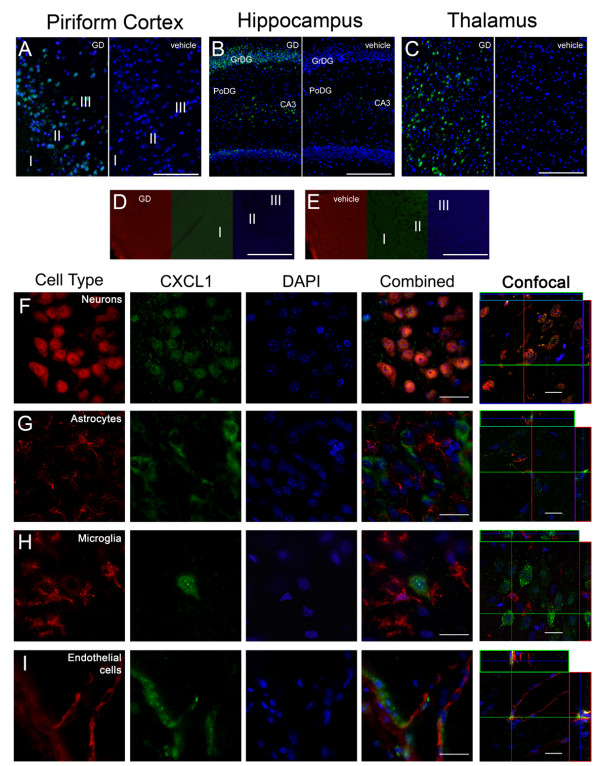
CXCL1 is expressed in neurons and, to a much lesser extent, in endothelial cells after GD-induced SE. Prominent CXCL1 (A-I, green) immunolabeling is present in the piriform cortex, hippocampus and thalamus 12 hours after GD-induced SE (A, B & C; left). CXCL1 is absent in vehicle controls of these same regions (A, B & C; right). In the piriform cortex (A), labeling is observed primarily in layers II and III. In the hippocampus (B), labeling was primarily confined to the CA3 pyramidal layer and granular layer of the dentate gyrus (GrDG) but not evident in the polymorphic layer of the dentate gyrus (PoDG). CXCL1 was located to the laterodorsal and lateral posterior nuclei of the thalamus (C). Labeling was absent in the secondary controls for both 12-hour GD-exposed (D) and vehicle control tissues (E), exemplified by the piriform cortex. Neurons (F, red) and CXCL1 were often found to co-localize (F, yellow). Co-localization was not observed in hypertrophic astrocytes (G, red) or activated microglia (H, red) and was limited in endothelial cells (I, yellow). DAPI (A-I, blue) was used to label the nuclei of each cell. Scale bar: 250 μm (A-E), 50 μm and 20 μm (F-I) for regular and confocal fluorescent microscopy respectively; n = 7 for 12-hour, n = 4 for vehicle controls.